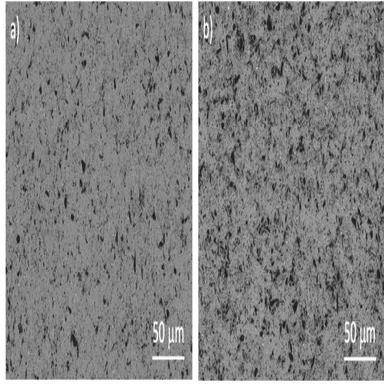
SEM Micrographs of Al/B4C composites in backscattering electrons for (a) 4 vol.% B4C and (b) 10 vol.% B4C.